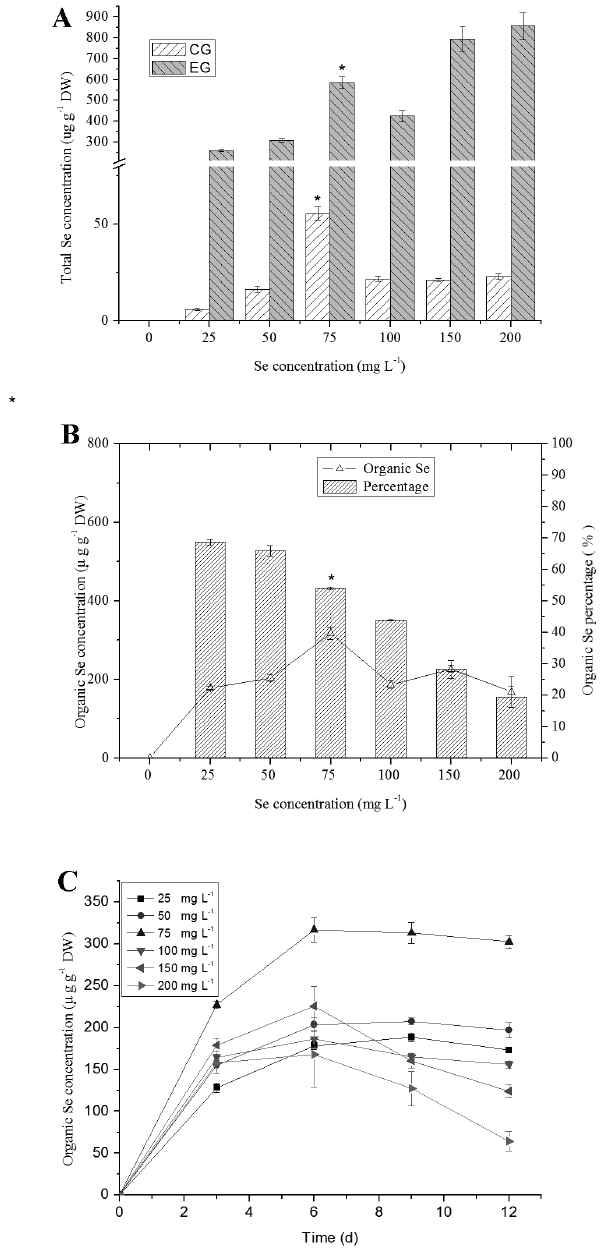
Figure 1. Accumulation of Se in C. vulgaris. (A) Total Se concentration. The control groups (CG) were spiked with 25–200 mg L 2 1 selenite within 5 minutes on the ice right before harvesting samples and the total Se content was determinated. The experiment groups (EG) were cultured at different Se concentrations for 6 days. (B) Organic Se concentration at day 6. (C) Changes in Organic Se concentration of C. vulgaris during cultivation time of day 3, 6, 9 and 12 at different Se concentrations. The single asterisk * in the figure represents significant difference of 75 mg L 2 1 Se treatments compared to other Se treatments (25, 50, 100, 150, 200 mg L 2 1 ) ( P , 0.05). Values expressed are means 6 SD of three replicates.